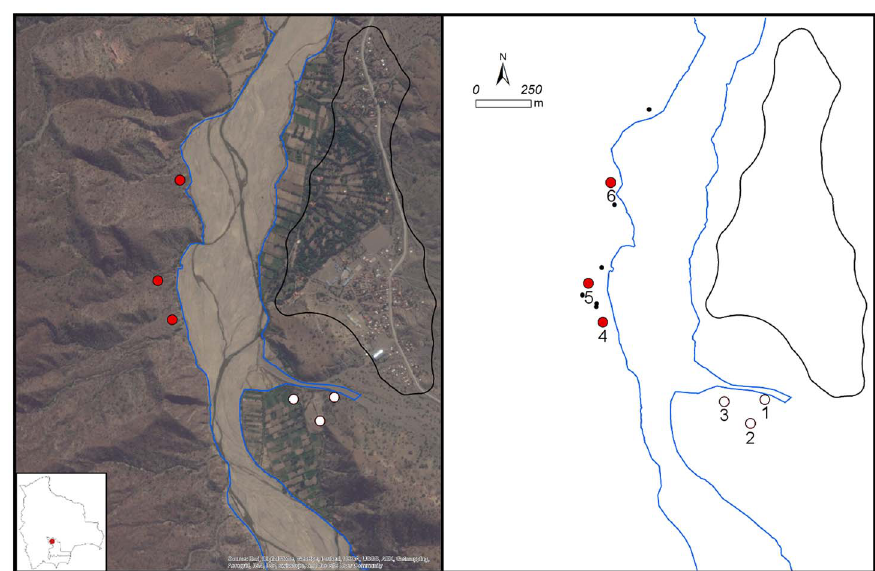
Figure 1. Satellite imagery ( , 1 m resolution, ArcGIS, Ver. 10.1, ESRI Inc., Redlands, California, USA [26]) centered on the riverbed of Rio Chico near the town of Zurima (left). Digitized town boundary (black polygon), riverbed (blue lines), six isolated houses (small black dots) and numbered locations of the positive (red fill) and negative (white fill) trap sites.